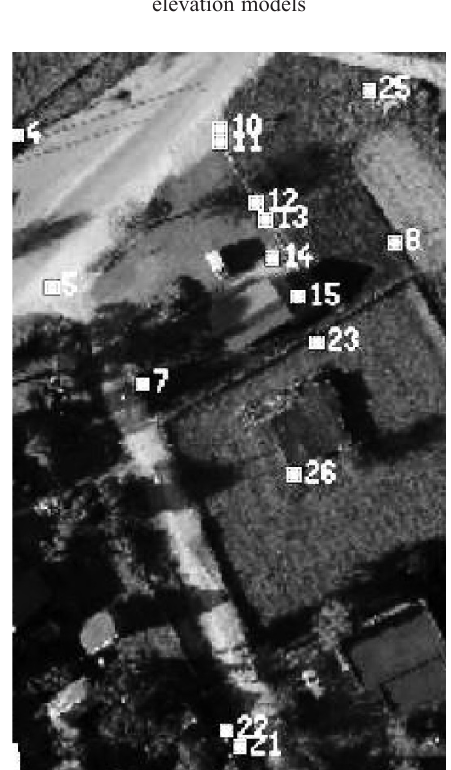
Fig. 10. Principle diagram for checking of digital elevation models